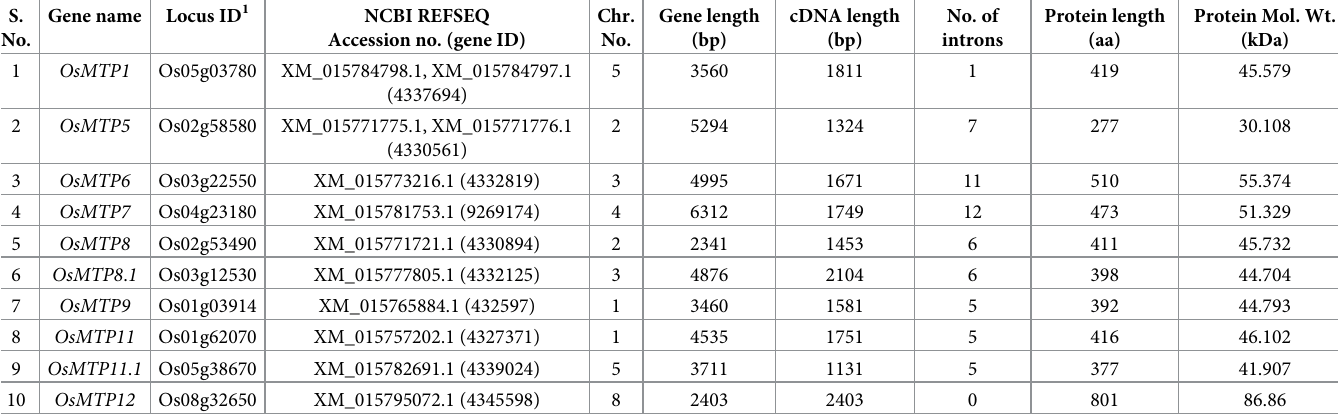
Table 1. Details of the metal tolerance protein (MTP) genes identified in rice genome. S. Gene name Locus ID No.